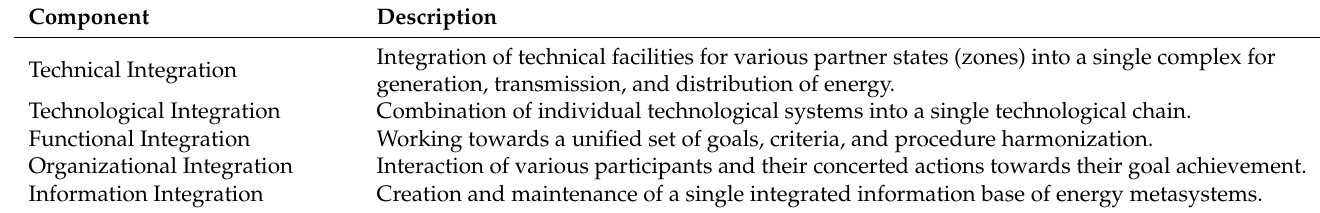
Table 2. Components of energy market